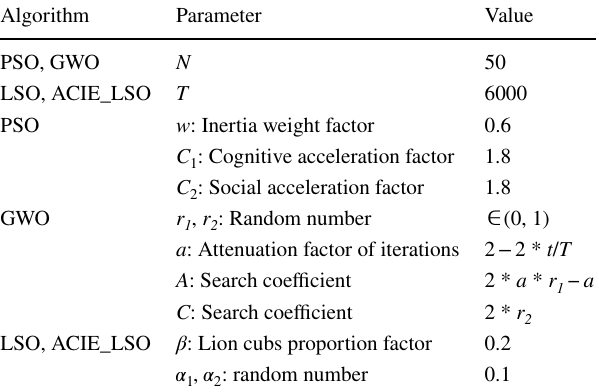
Table 2 Parameter setting of the comparison algorithms